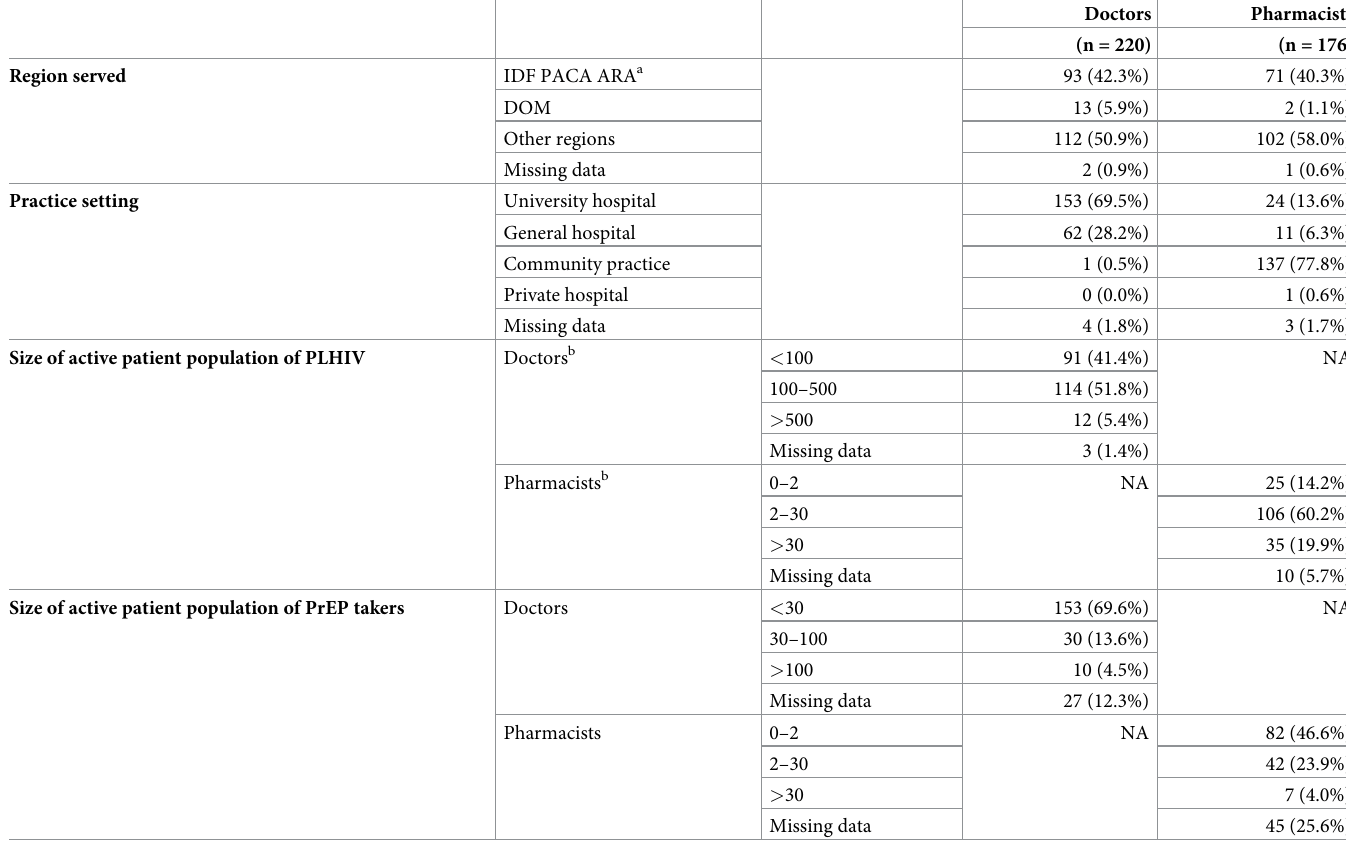
Table 2. Characteristics of the in-sample doctors and